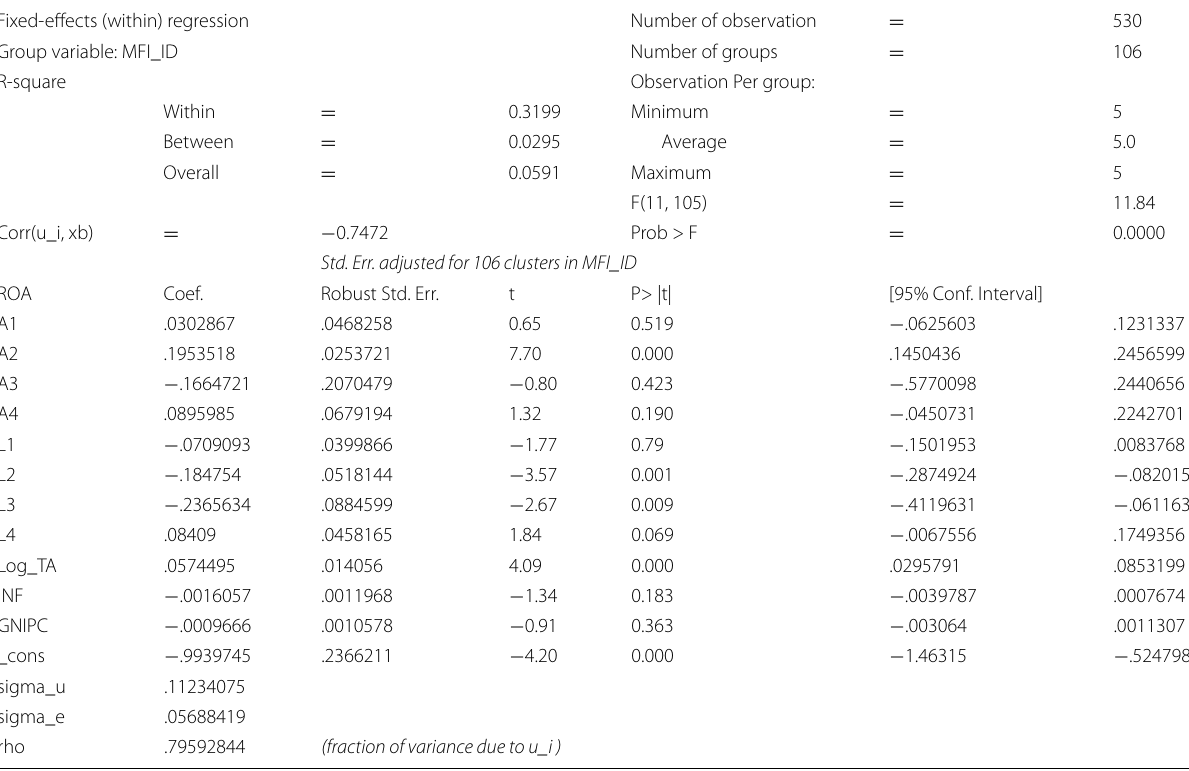
Fixed-effects (within)